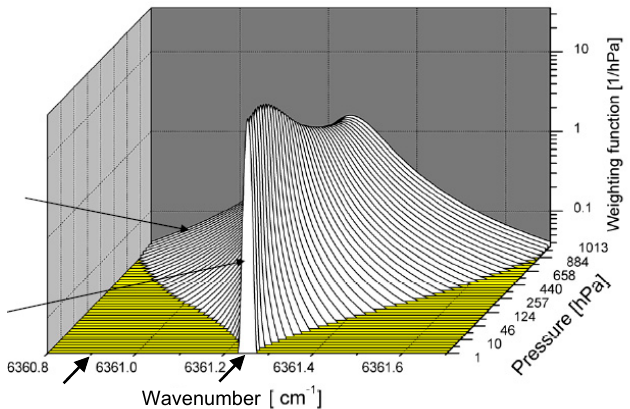
Figure 1. Weighting function (Equation (3)) illustrating the Doppler broadening of the 1.57 µm CO 2 absorption line due to increasing pressure and temperature (for p > ~124 hPa), as function of wavenumber and atmospheric pressure, using a Voigt line shape model [24]. Positioning the online Lidar wavenumber in the far line wing (at 6360.9 cm − 1 ; left arrows) lowers the weighting function at constant pressure levels yet makes it peak at maximum pressure, giving a high IPDA measurement sensitivity at the surface where most CO 2 sources and sinks are located. An alternative position close to the line center with a less altitude-dependent WF is indicated by the other pair of arrows.